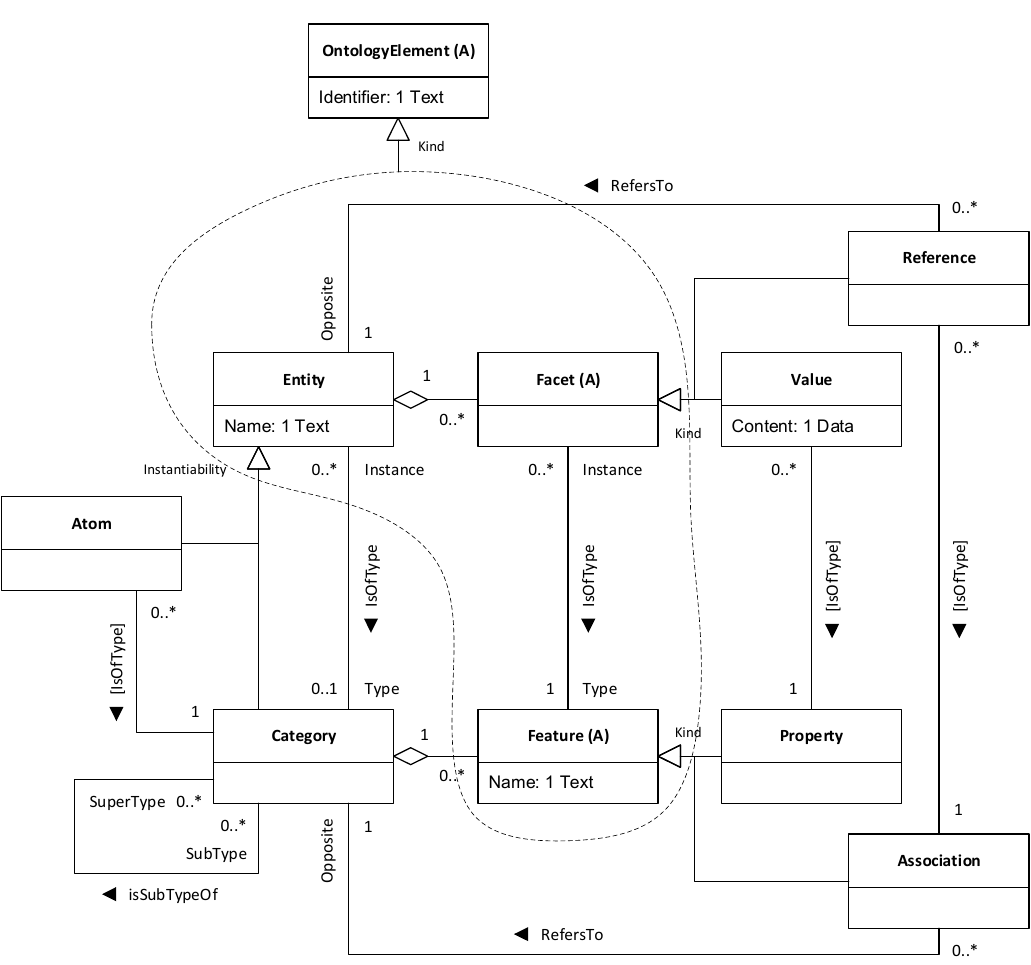
Figure 7. Part of the IAT + metamodel showing the class hierarchy under OntologyElement . Please see the text below for a detailed description of each model element.